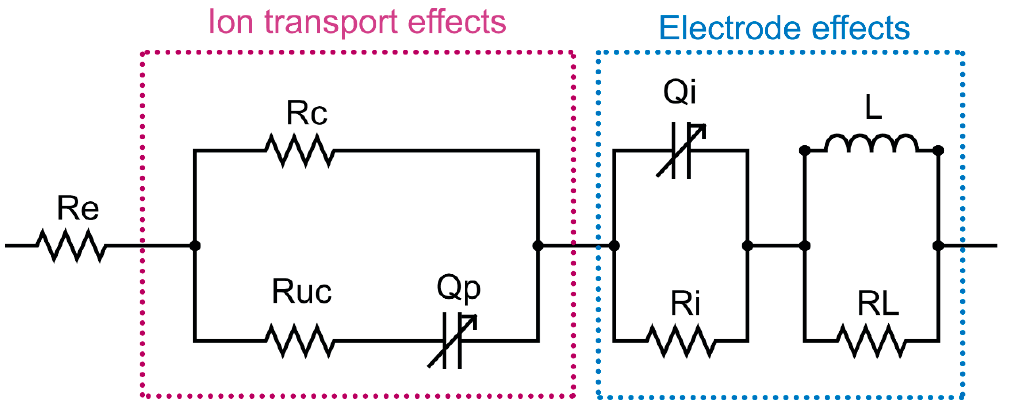
Figure 2. Equivalent circuit of AAM [65].